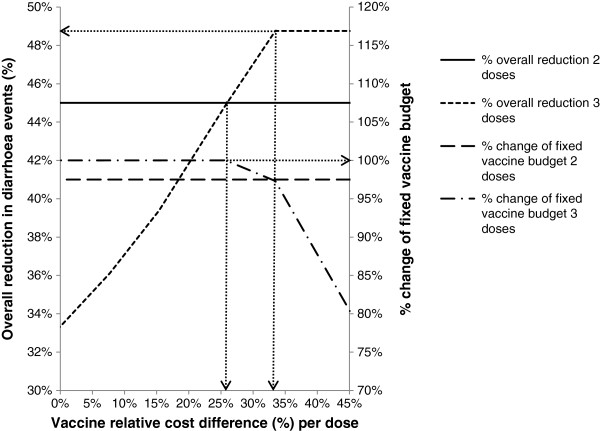
Effect of the difference in vaccine cost per dose on budget and effect. Reduction in diarrhoea events (left Y-axis) and relative change of vaccine budget constraint (=100%) (right Y-axis) as a function of the relative cost difference per vaccine dose. Assumptions: vaccine budget, $200,000; 2-dose vaccine efficacy (strategy A), 60%; 3- dose vaccine efficacy (strategy B), 65%; target vaccine coverage, 75%; 2-dose vaccine cost per dose (strategy A), $13.00; 3- dose vaccine cost per dose (strategy B), allowed to vary.